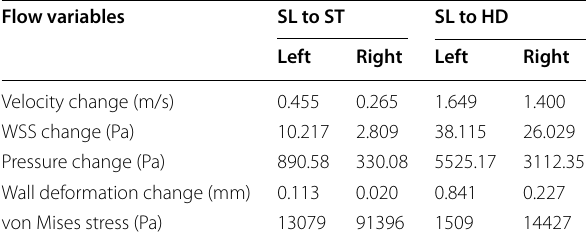
Table 1 Assessment of haemodynamics parameters observed in aneurysm and normal side ICA bifurcation during different postures